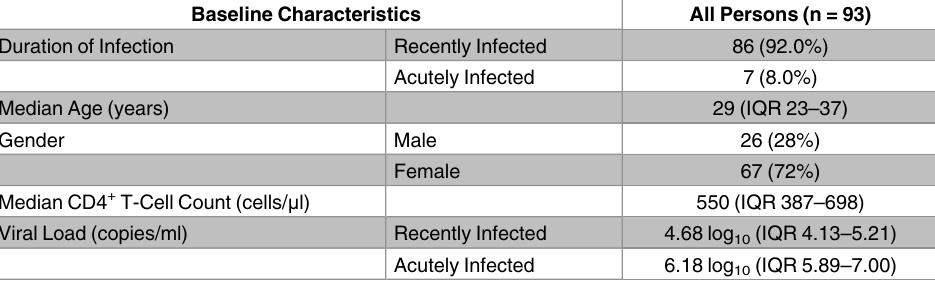
Table 1. Demographic and clinical characteristics of acutely and recently HIV-1 infected antiretrovi- ral-na ï ve persons in the Ndhiwa cohort, Kenya,